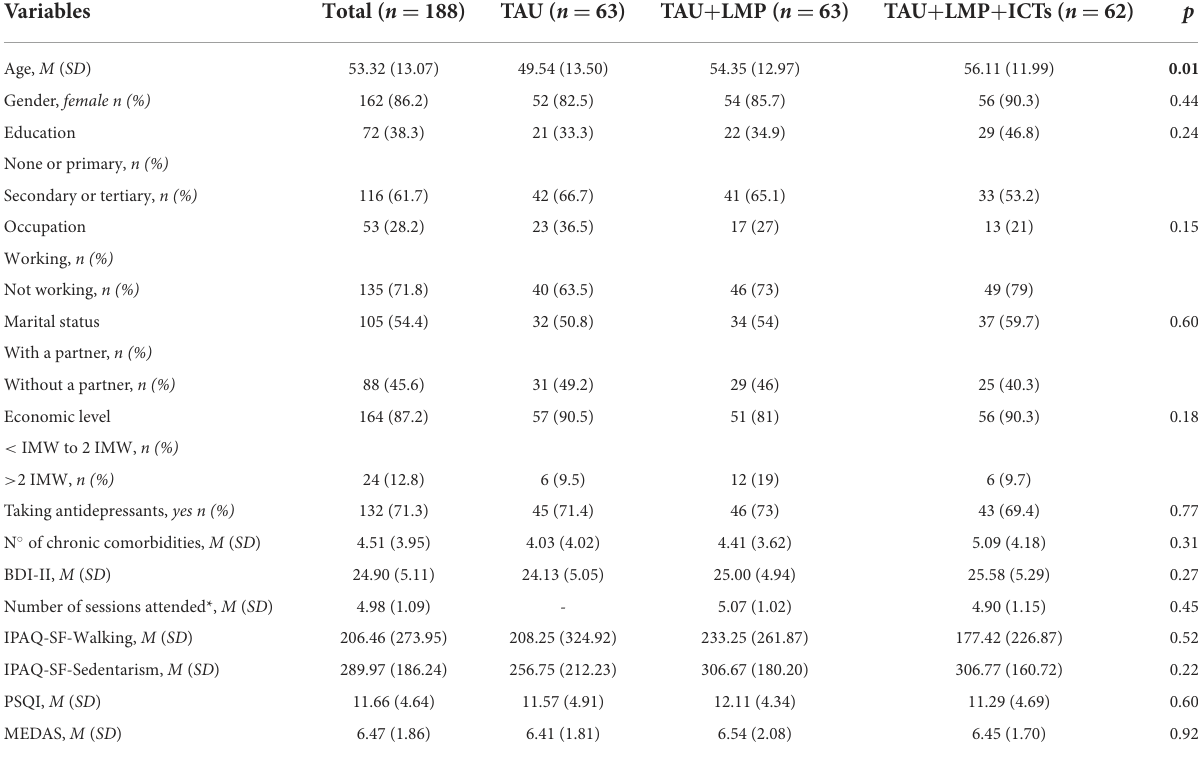
TABLE 1 Sociodemographic and clinical characteristics of the